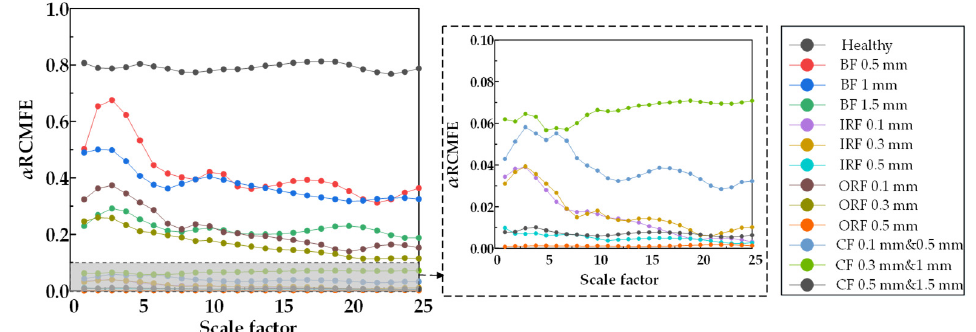
Figure 24. α RCMFE entropy values of 25 scale factors under different damage degrees.